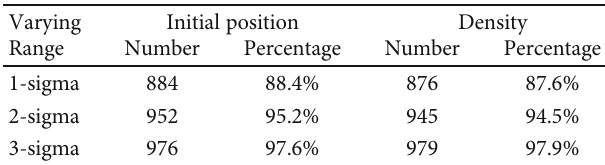
Table 12: Con fi dence interval for Monte Carlo simulation in the Mars